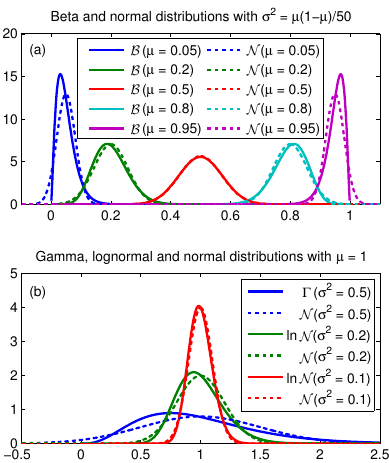
Figure 4. Examples of (a) beta and (b) gamma and lognormal dis- tribution compared with their analogous normal distributions using the same mean ( µ ) and variance ( σ 2